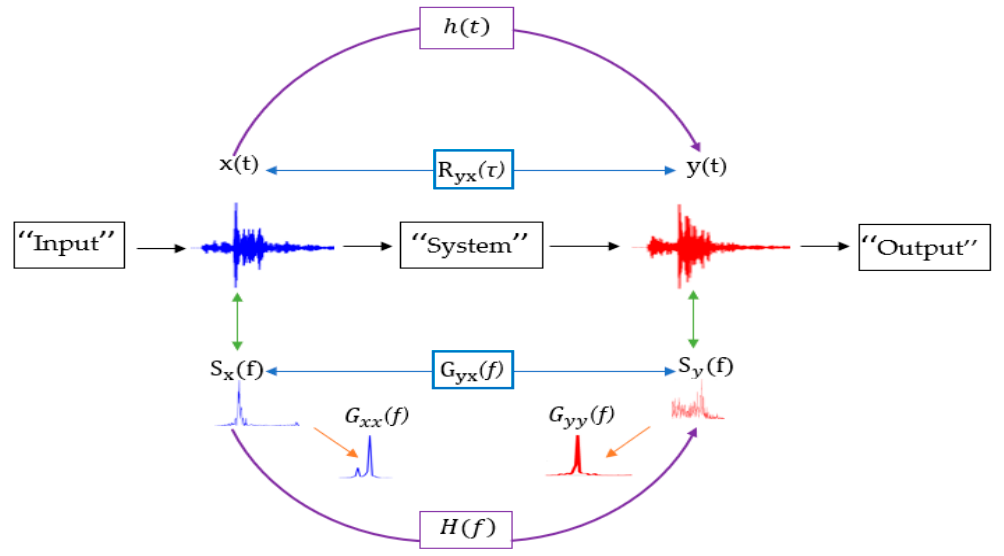
Figure 6. Nonparametric processing functions.